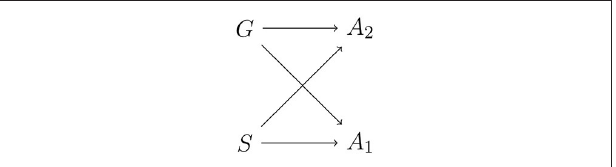
FIGURE 12 | Schematic of a policy where the behavioral G and the perceptual state S determine two actions A 1 and A 2 to be performed by different